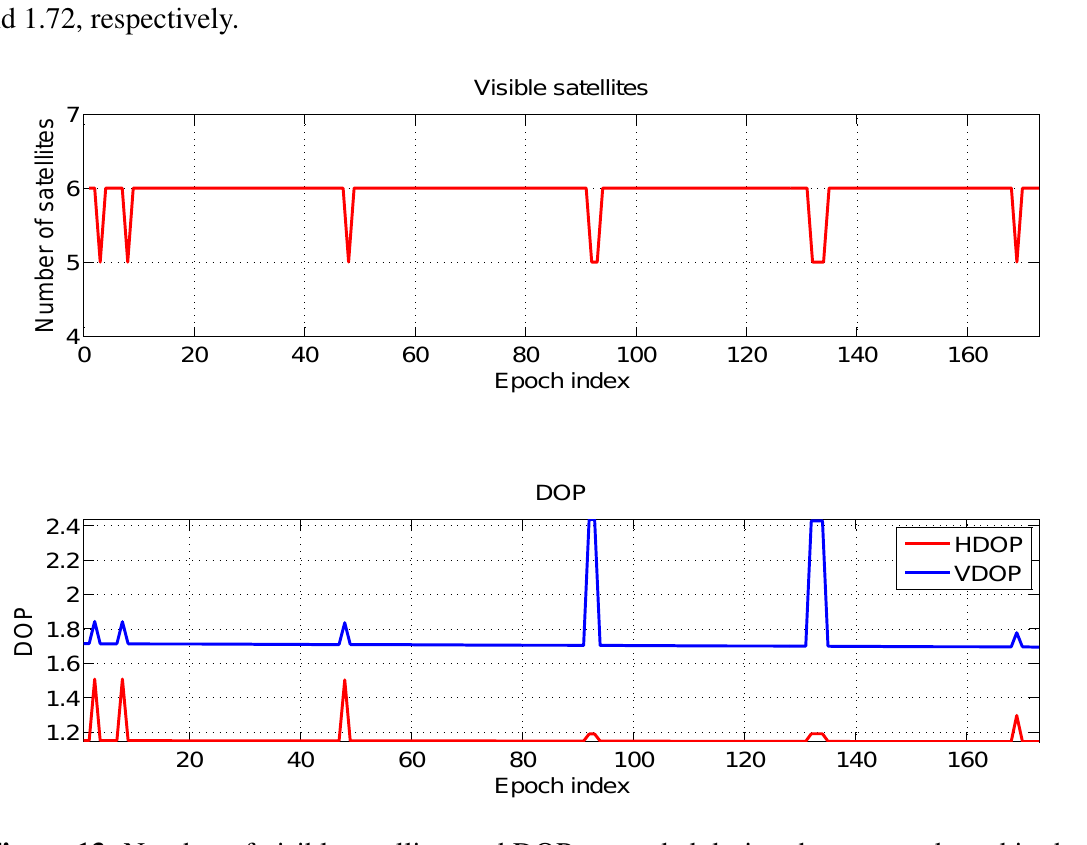
Figure 13. Number of visible satellites and DOPs recorded during the test conducted in the outdoor